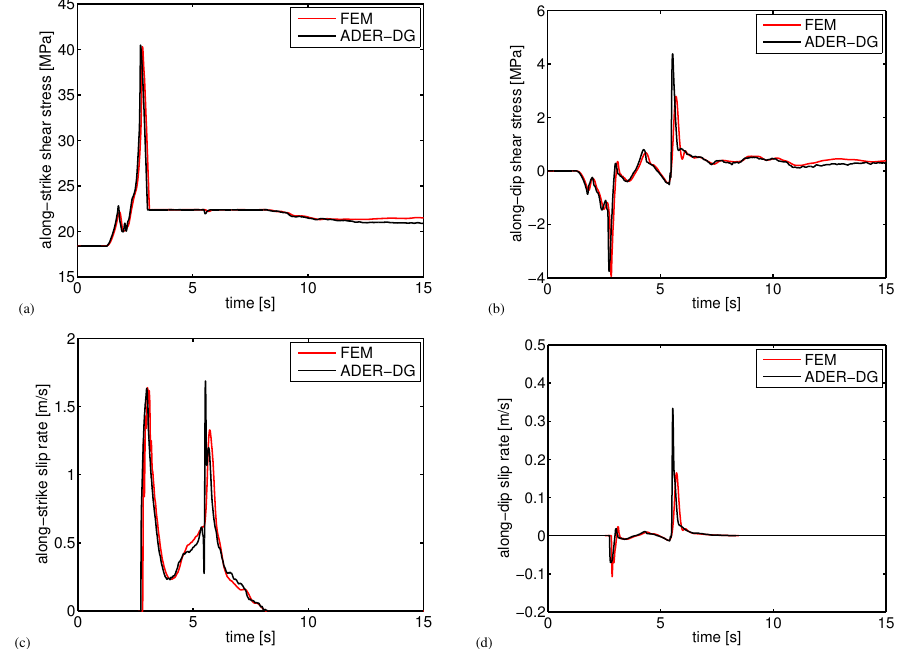
Fig. 5. Shear stresses and slip rates for TPV17 on a fault location at 9km depth and − 9km along strike. A sharp feature caused by an interface wave can be identified in the along-strike slip rate (c) at t ∼ 5 . 5s. The ADER-DG solution is shown in black, the FEM comparison solution in red.